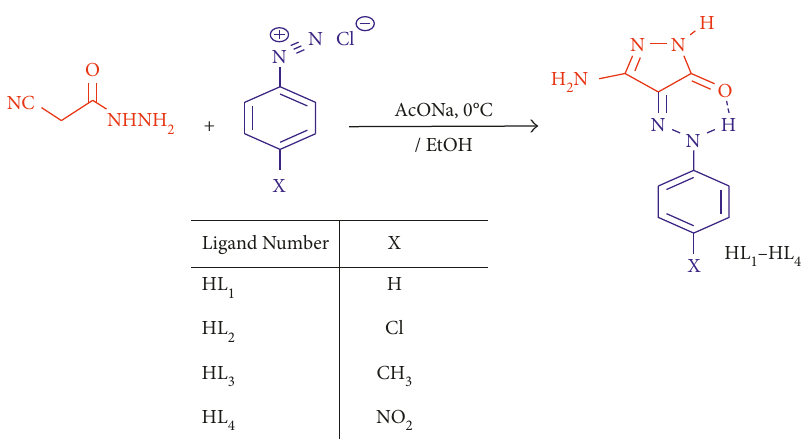
Scheme 1: Synthesis of pyrazolone ligands (HL 1 –HL 4